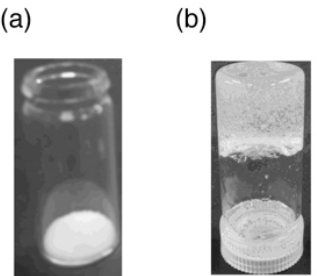
Figure 2 . Photo images of ( a ) CPAM (100 mg) and ( b ) gel of CPAM absorbing the saturated amount of anhydrous hydrazine.